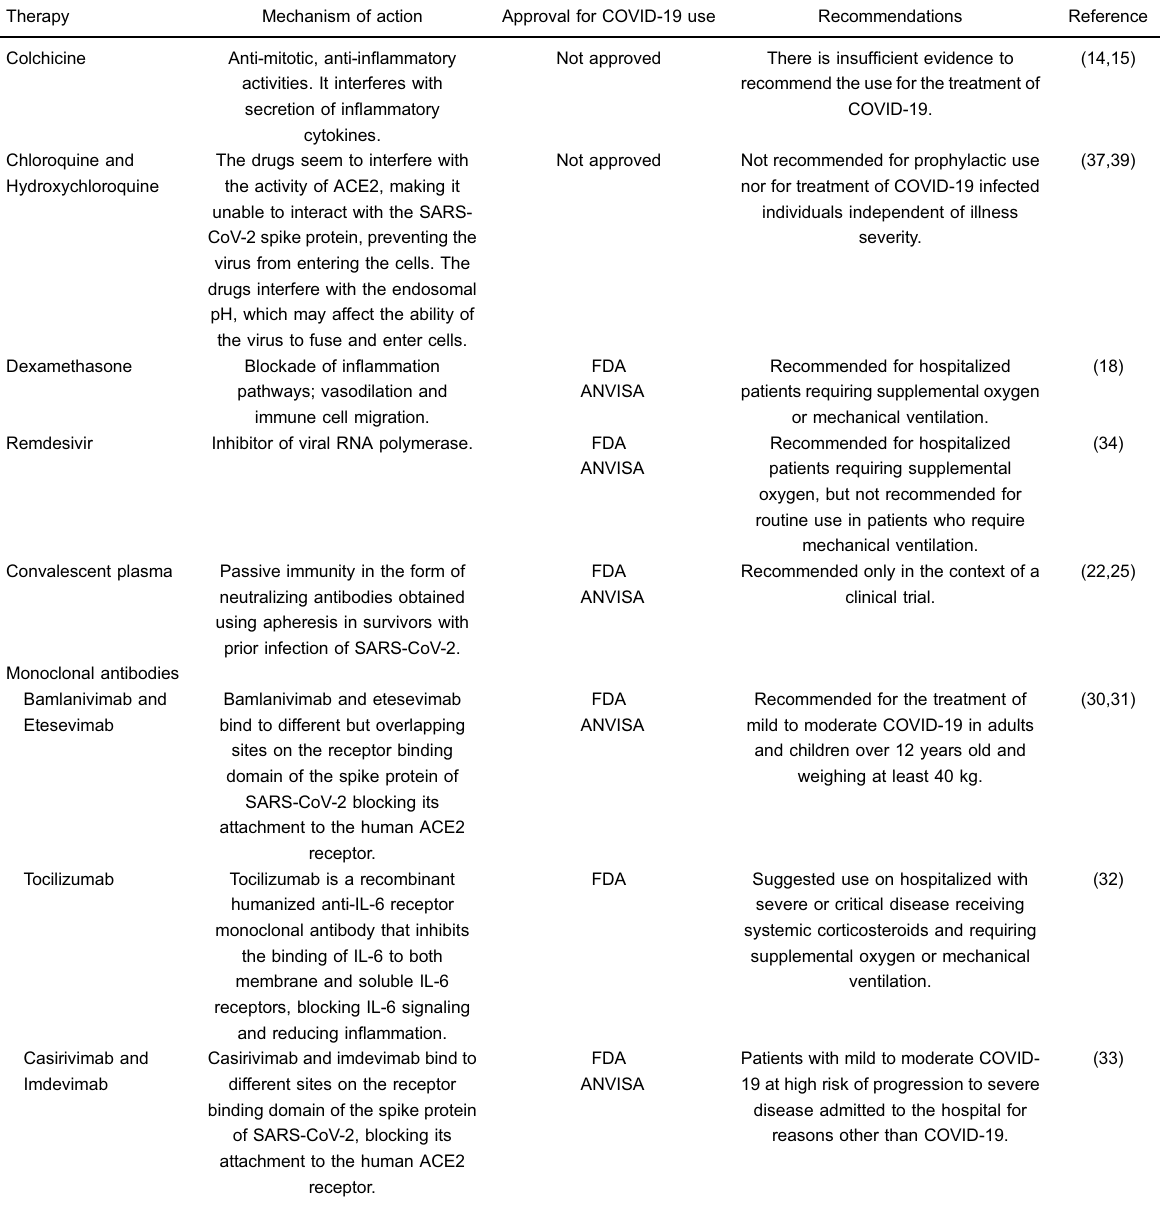
Table 1. Current therapeutic options for